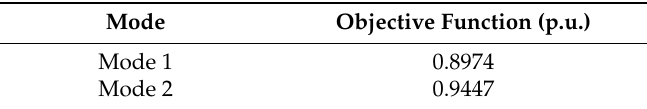
Table 4. Objective function of the optimal configurations.